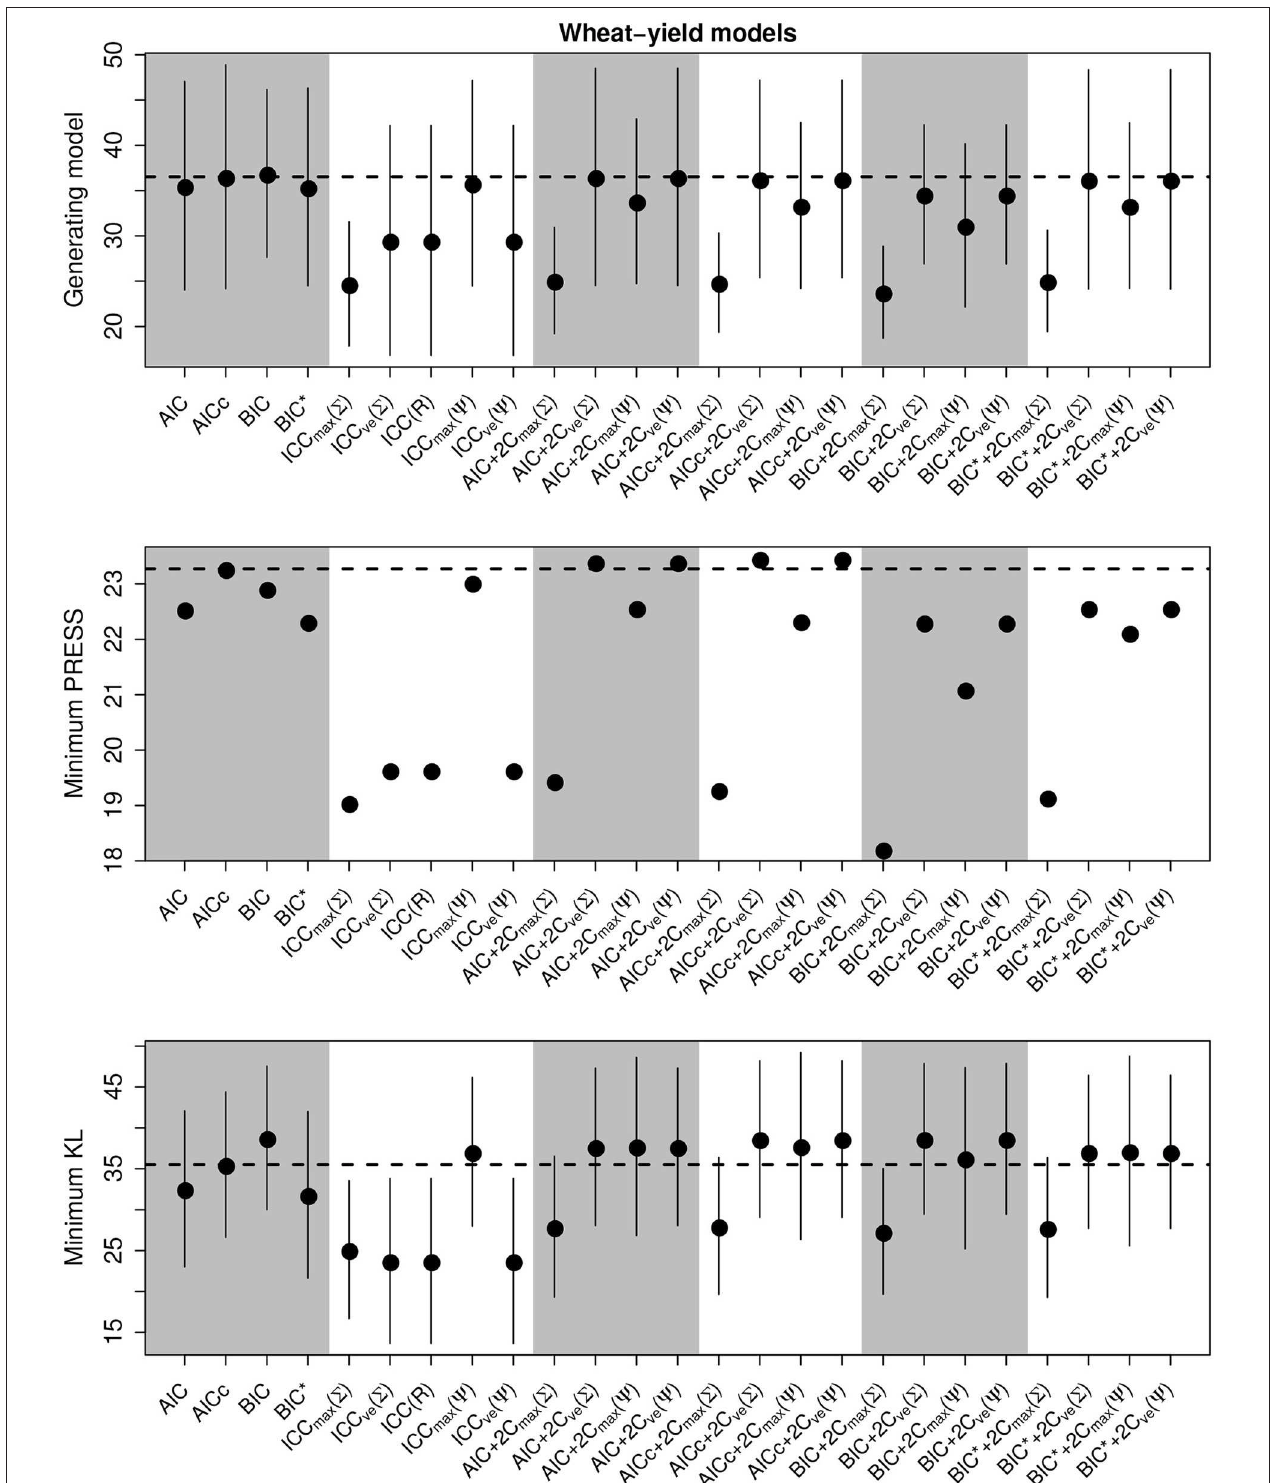
FIGURE 4 | Performance of the criterion for all selection goals for the nonlinear barley yield simulation experiment. Points are the average performance-level, bars give standard errors. The top panel gives the frequency that each criterion selects the model used to generate the data, the middle pannel gives the frequency of selecting the model that minimizes the predicted residual error sum of squares (PRESS), while the bottom panel gives the frequency of selection by the criterion of the model corresponding to the minimum Kullback-Leibler divergence (KL). No error bars are present in the PRESS results becauase we did not repeat these experiments.